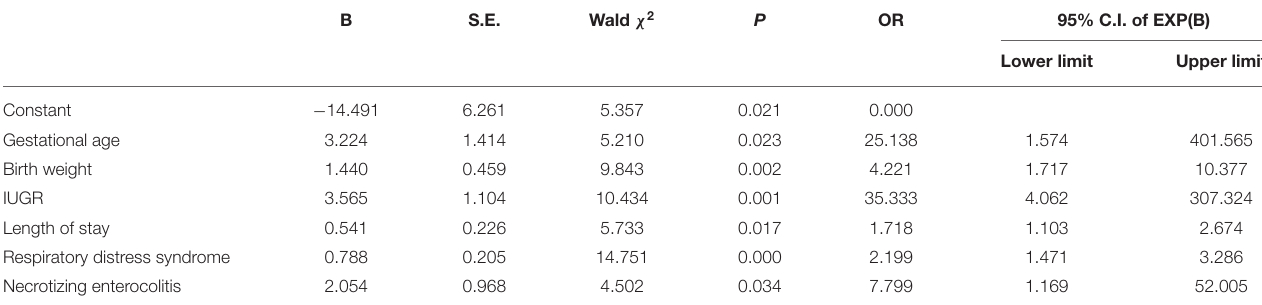
TABLE 6 | Multivariate logistic regression analysis of the risk factors for the occurrence of